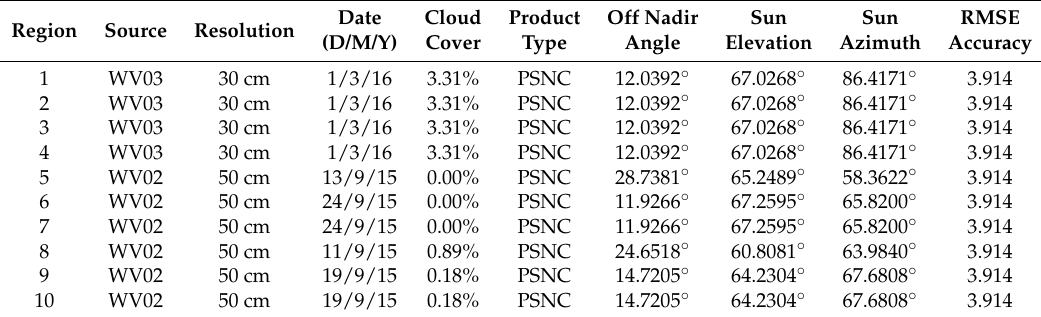
Table A1. Metadata for WorldView imagery used (all scenes are Pan Sharpened Natural Color). Regions correspond to the areas in Figure 2.